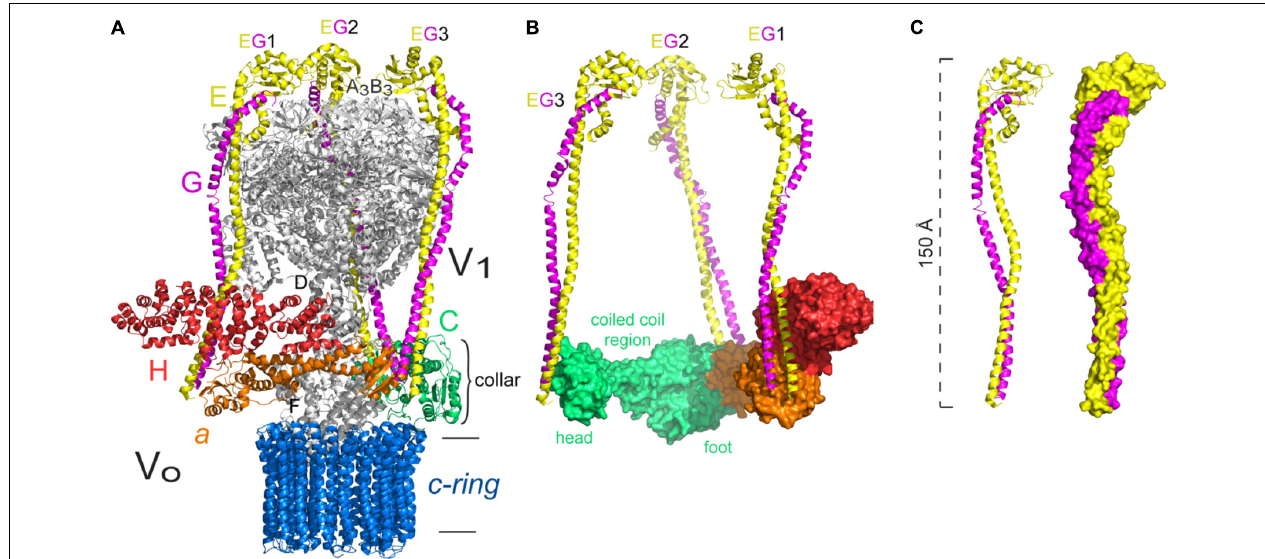
FIGURE 6 | Peripheral stalk of the Saccharomyces cerevisiae V-ATPase. (A) Three dimensional model of the yeast enzyme in which the peripheral stalks and the subunits of the collar-like structure are colored. (B) Model that illustrates the interaction of each peripheral stalk (EG1, EG2, EG3) with the subunits of the collar. The different sections of subunit C are indicated. (C) Models of the EG heterodimer to illustrate the right handed coiling of the helices. The model used in A–C corresponds to structural data deposited with the PDB 3J9V (Zhao et al., 2015). The black horizontal lines indicate the mitochondrial inner